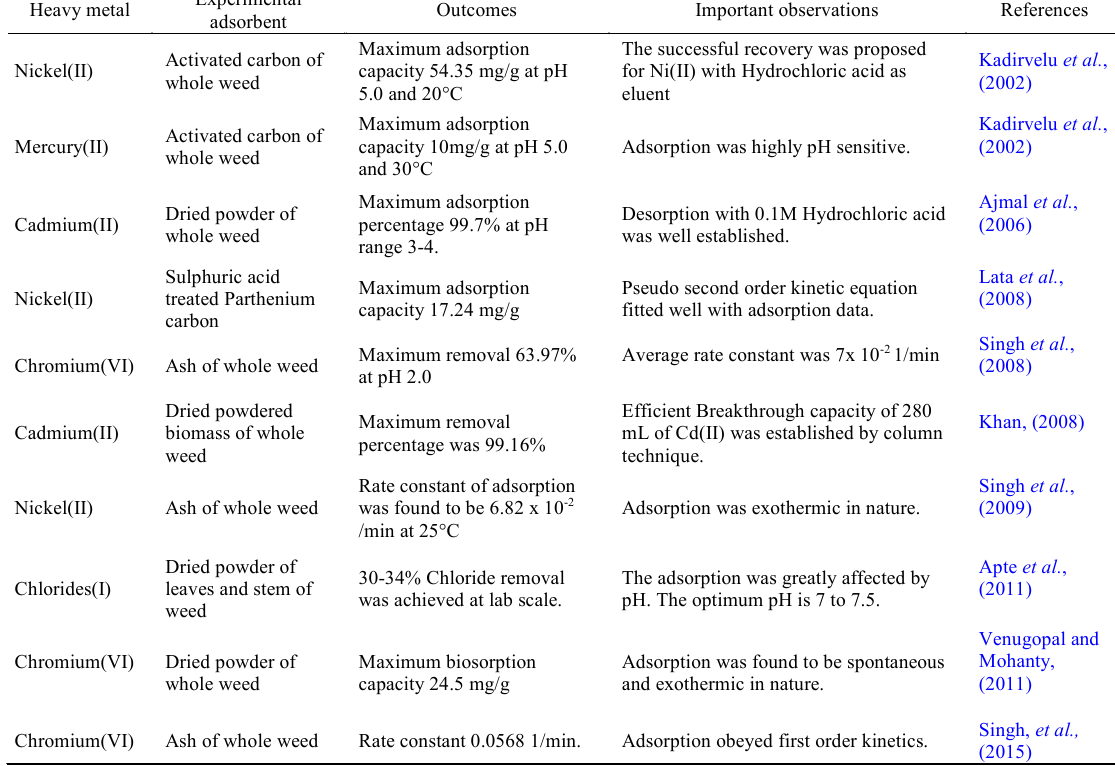
Table 1: Parthenium hysterophorus for removal of heavy